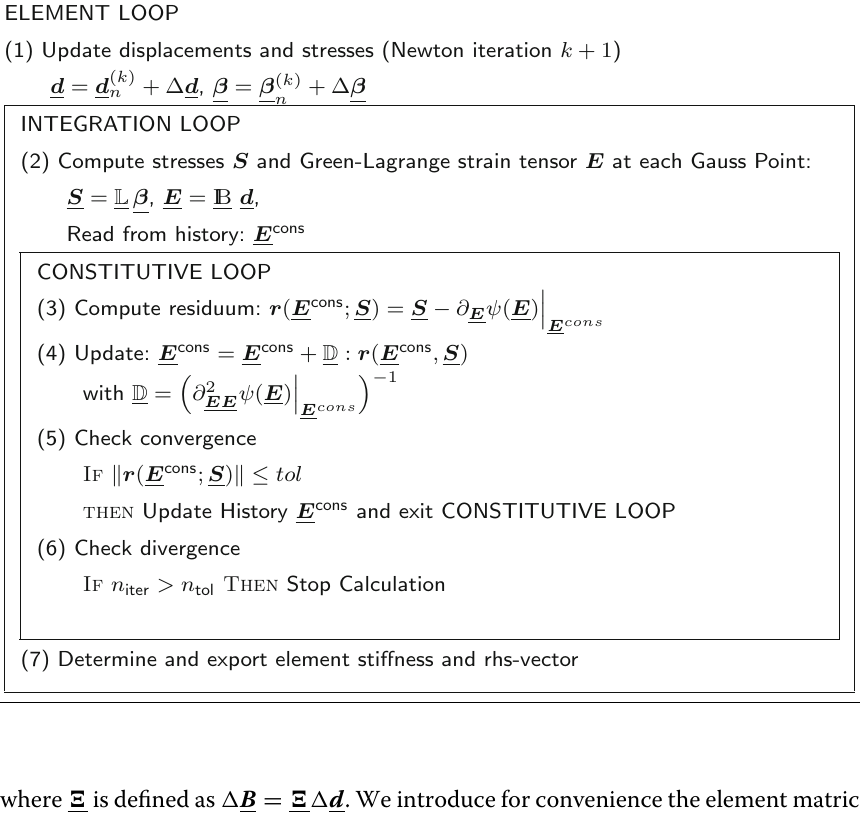
Table 2 Nested algorithmic treatment for a single element ELEMENT